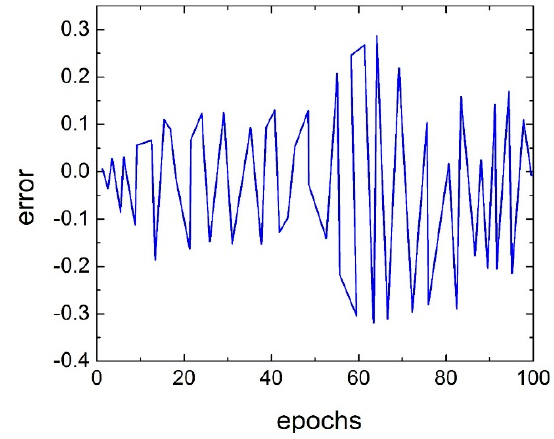
Figure 4. The fitting error rate curve of the least squares method.